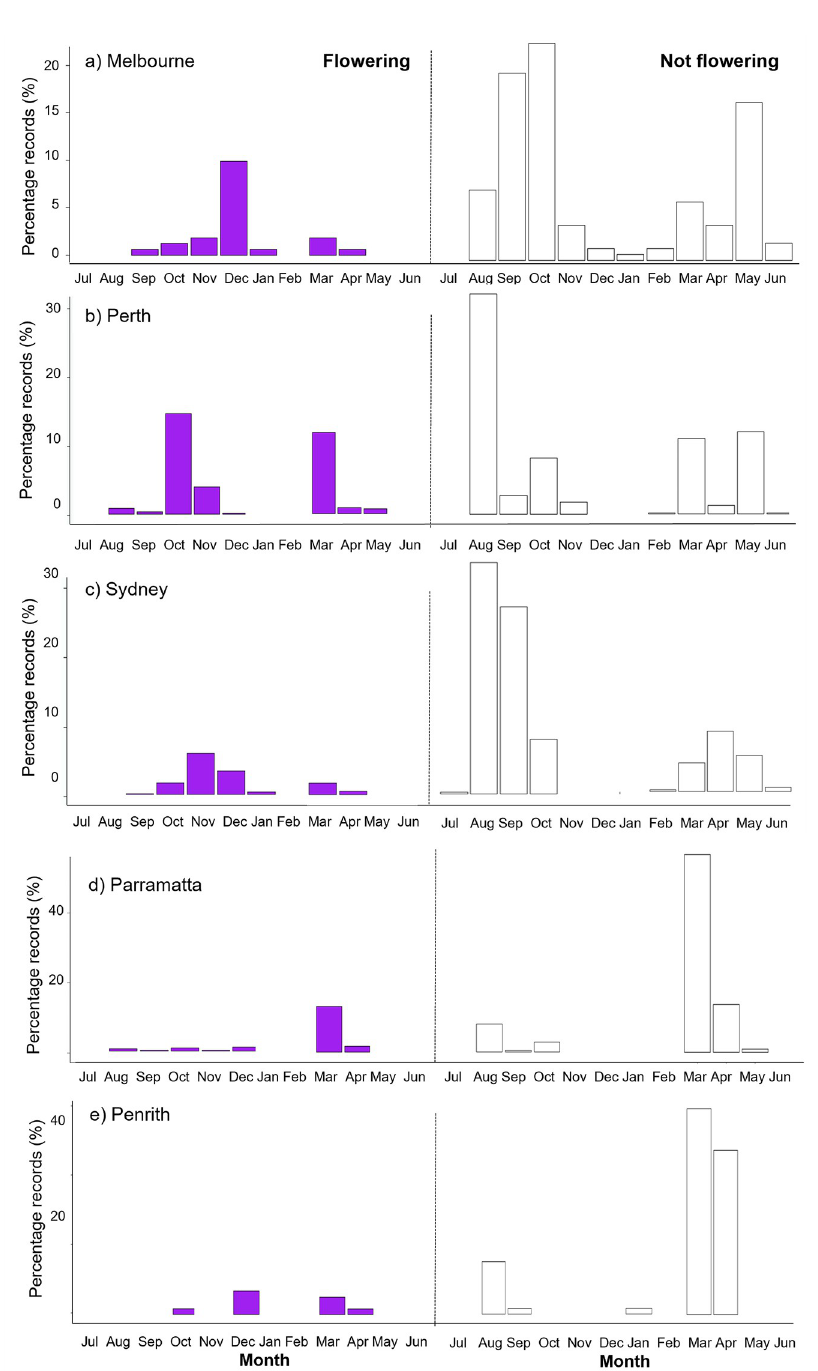
Fig 3. Monthly trends of Jacaranda flowering and non-flowering in the five stations according to ClimateWatch citizen science data between 2009–2019.